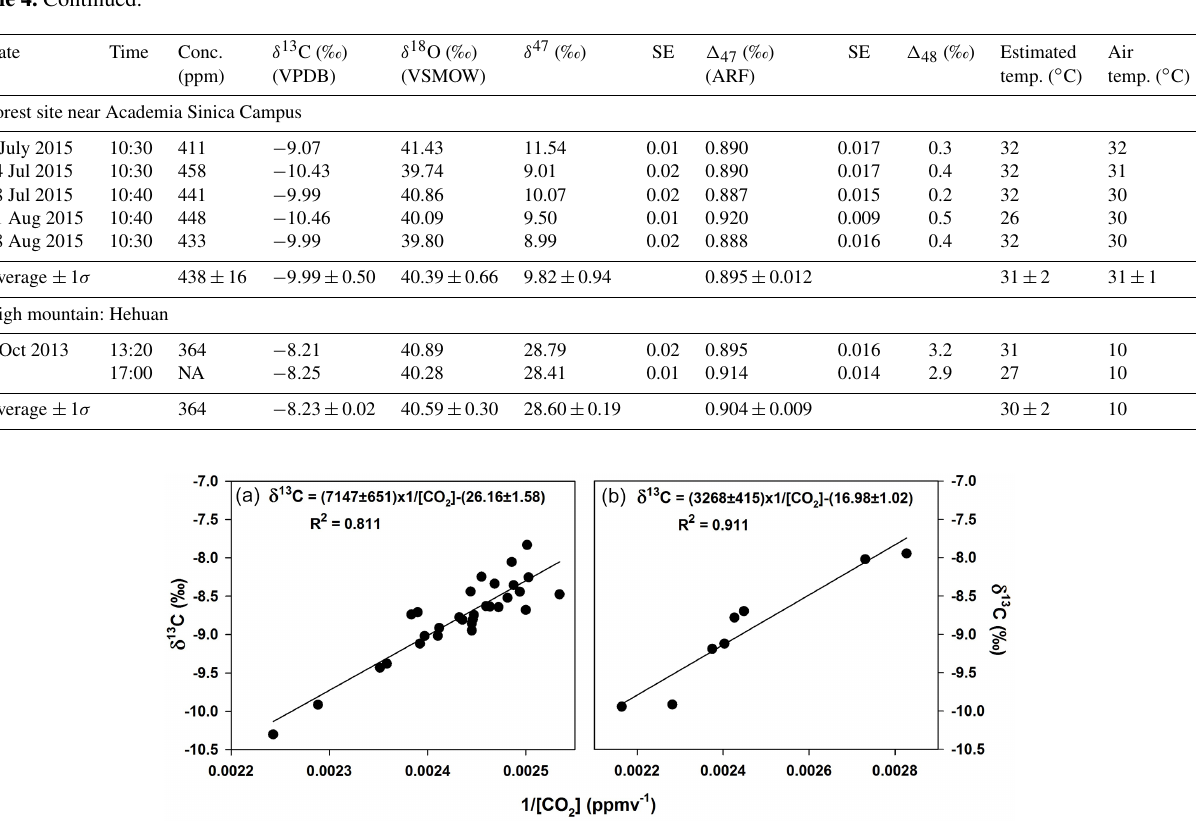
Figure 6. Carbon Keeling plots for air CO 2 collected over (a) suburban Academia Sinica Campus and (b) grassland at National Taiwan University